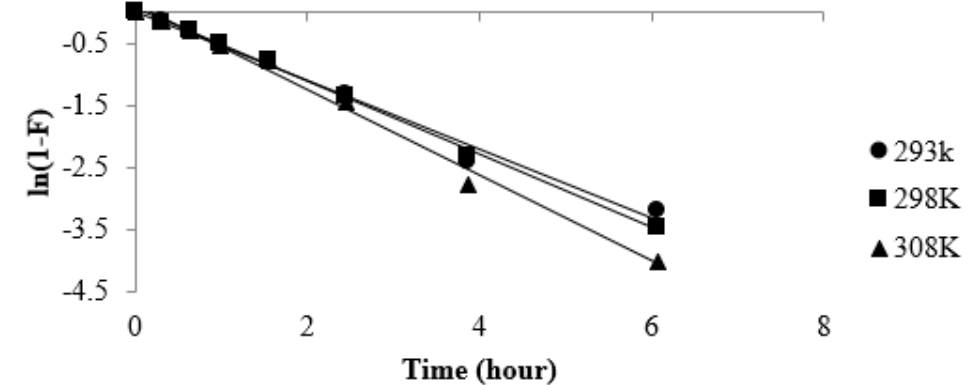
Figure 10. Effect of temperature on strontium diffusion onto the CF beads.